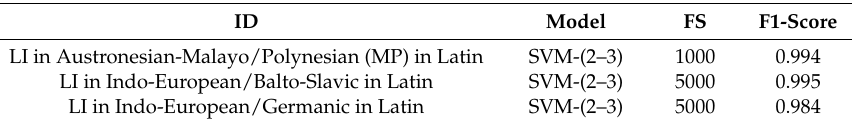
Table 22. Selected OCM for SLGI in three LG in four-stage LI.